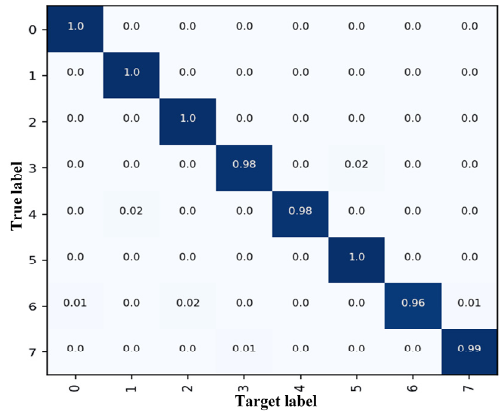
Figure 11. Confusion matrix of recognition rate.